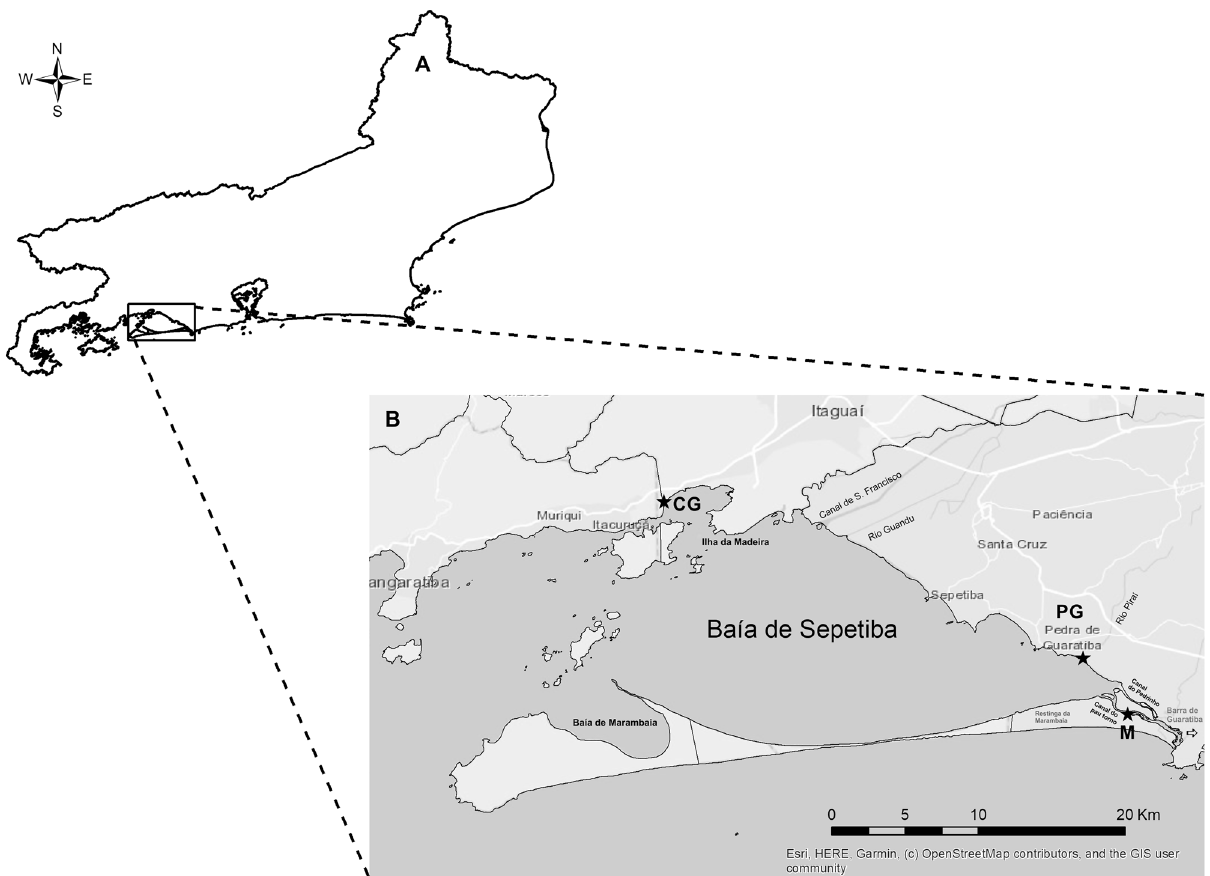
Figure 1. ( A ) Rio de Janeiro City. ( B ) Mangroves around Sepetiba Bay where Laguncularia racemosa leaves were collected (*). Black stars indicate areas of plant collection in mangroves: Coroa Grande—CG (Itaguaí City), Pedra de Guaratiba—PG (Rio de Janeiro City) and Marambaia—M (Rio de Janeiro City). Industrial centers are found in Itaguaí and Santa Cruz. ArcMap 10.6 program.